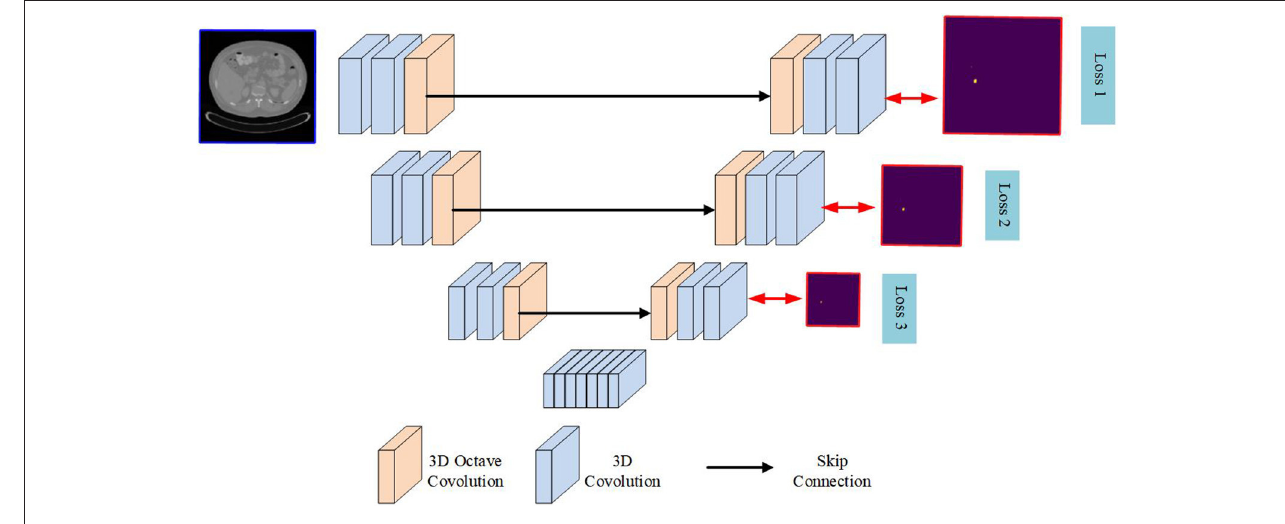
FIGURE 3 | Detailed network architecture of the proposed network.